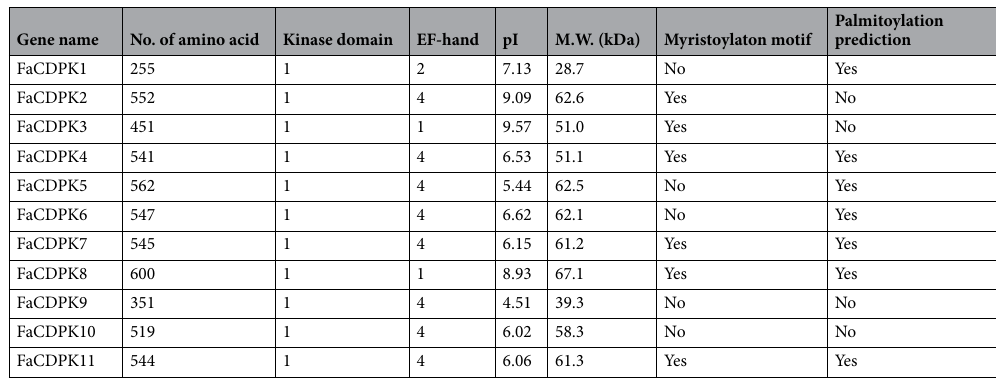
Table 1. Information on the sequences of calcium-dependent protein kinase (CDPK) identified in strawberry ( Fragaria x ananassa